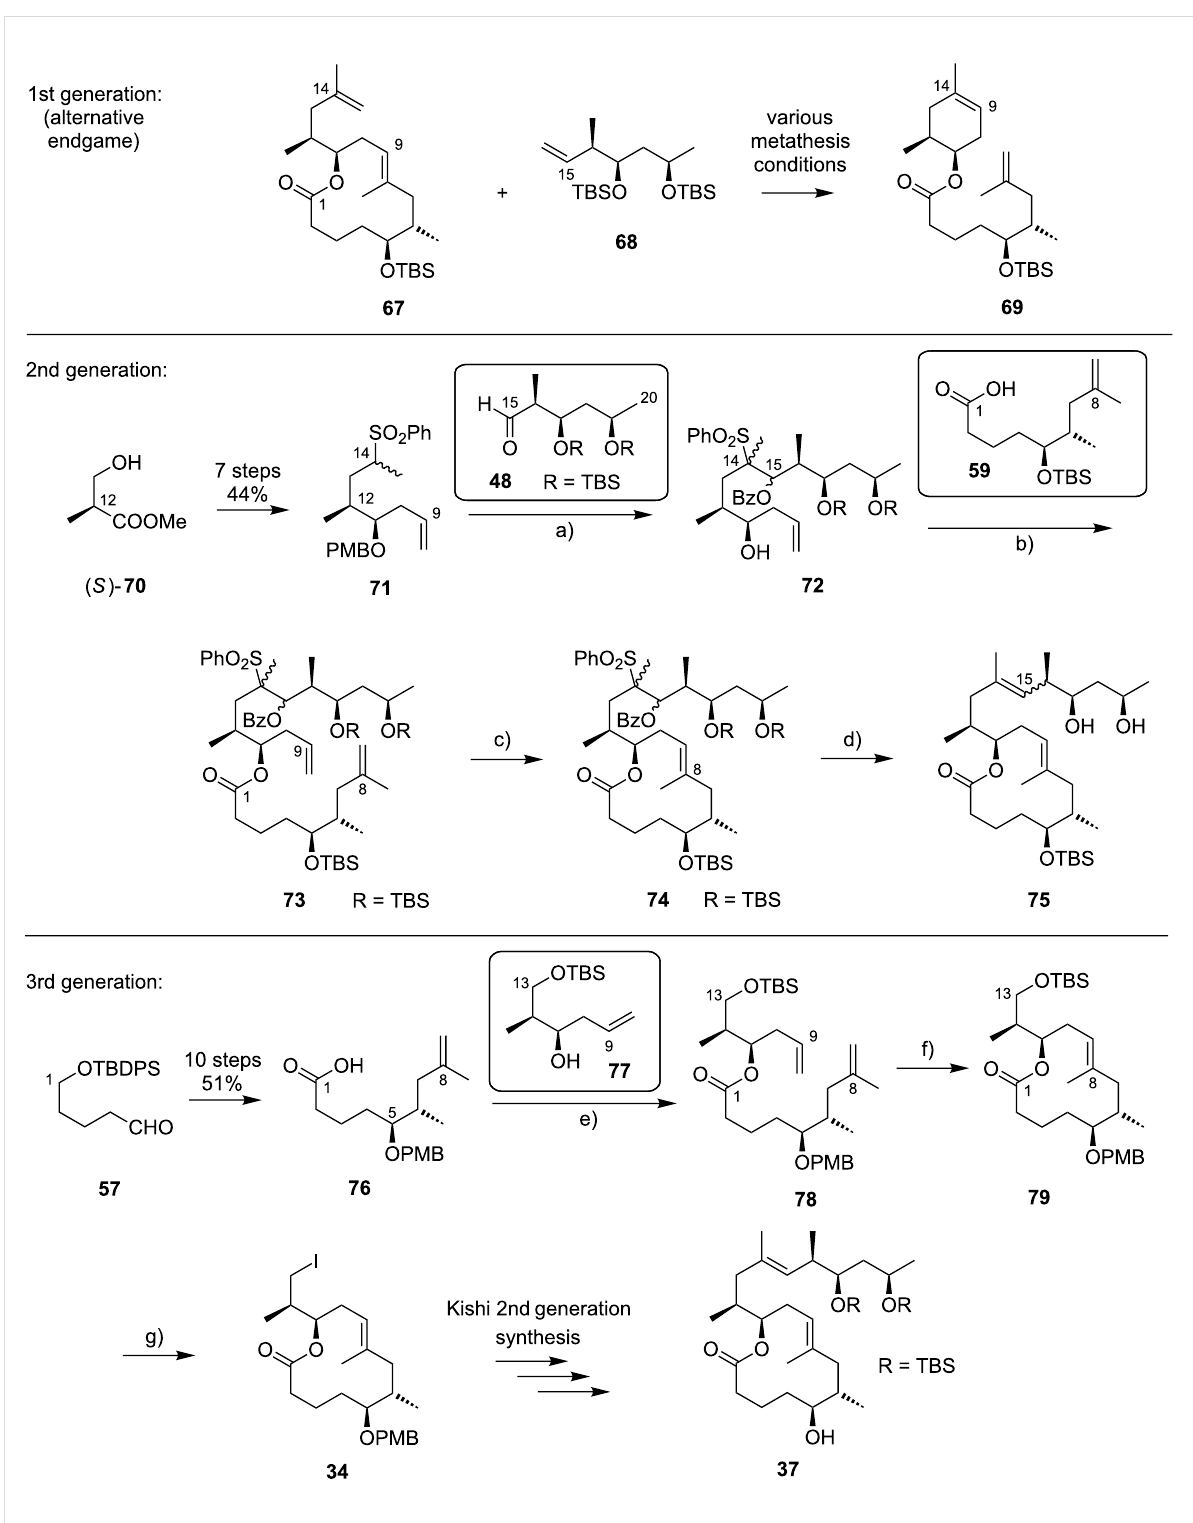
Scheme 6: Burkart’s (incomplete) 1st, 2nd and 3rd generation approach towards the extended mycolactone core structure. Reagents and conditions: a) (i) n -BuLi, THF, − 78 °C to − 20 °C, then 48 , THF, − 78 °C to − 20 °C, then BzCl, − 78 °C to rt, 57%; (ii) DDQ, wet CH 2 Cl 2 , rt, 95%; b) 59 , DCC, DMAP, CSA, CH 2 Cl 2 , 0 °C to rt, 96%; c) Grubbs II (4.3 mol %), CH 2 Cl 2 , reflux, 94%; d) (i) Na/Hg, MeOH, − 20 °C, 90% ( E / Z 2:1); (ii) TASF, DMF, 42% of E -isomer and 19% of Z -isomer; e) DCC, DMAP, pyridine, CH 2 Cl 2 , 0 °C, 87%; f) Grubbs II, CH 2 Cl 2 , reflux, 78%; g) (i) TBAF, THF, 0 °C to rt, 85%; (ii) I 2 , PPh 3 , imidazole, toluene, 0 °C,